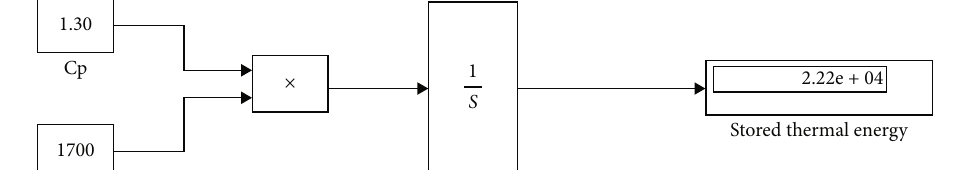
Figure 14: Simulink model of solar heating system.